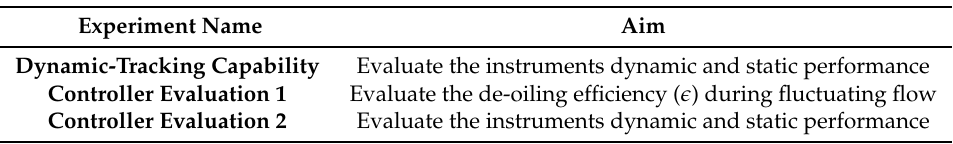
Table 3. List of experiments performed in this